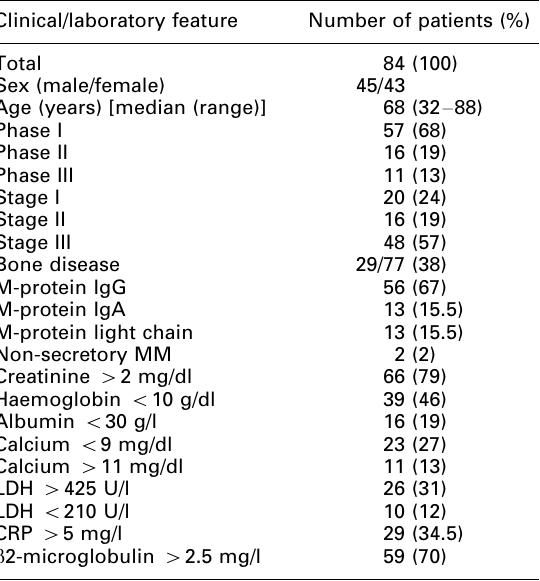
Table 1. Clinical and laboratory characteristics of MM patients Clinical/laboratory